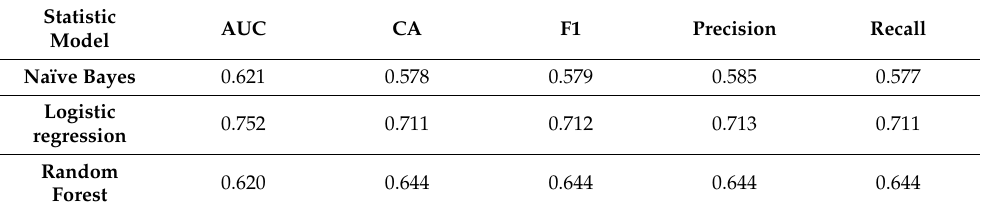
Table 3. Head-to-head comparison of the area under the curve results for the classification accuracy yielded by magnesium and uric acid using three supervised classification algorithms.